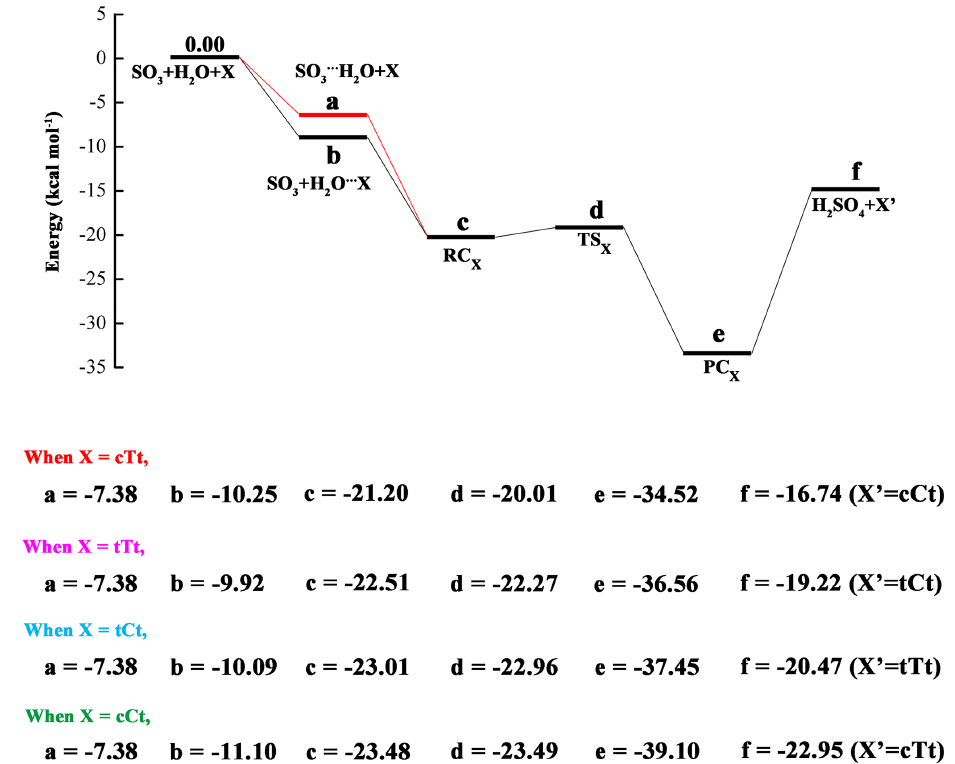
Figure 3. Calculated potential energy profile for the hydration of SO 3 with oxalic acid (OA) conformers (cTt, tTt, tCt and cCt) as catalysts at the CCSD(T)/cc-pV(T+d)Z//M06-2X/6-311++G(3df,3pd) level. Table 1. Rate constants (in cm 6 molecule − 2 s − 1 ) of the SO 3 hydration reaction catalyzed by water and by OA at different altitudes. Altitude